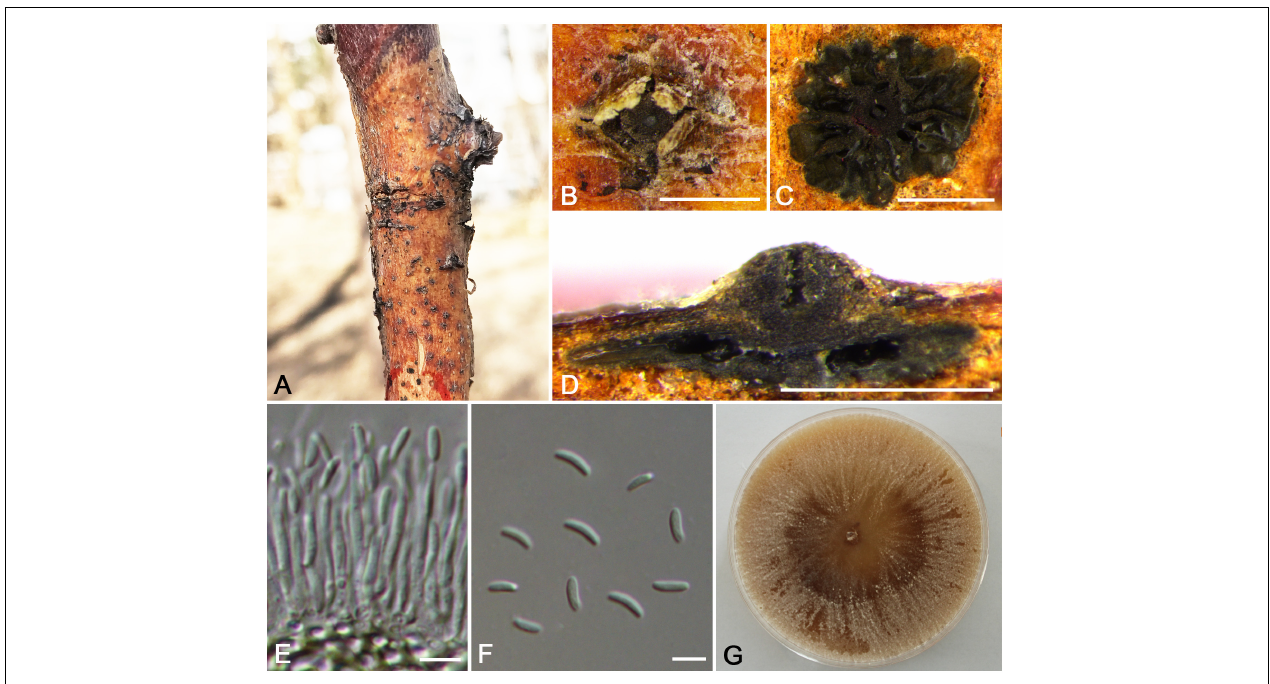
FIGURE 4 | Morphology of Cytospora cinnamomea from Prunus armeniaca (CF 20197654). (A,B) Habit of conidiomata on twig. (C) Transverse section of conidioma. (D) Longitudinal section through conidioma. (E) Conidiophores and conidiogenous cells. (F) Conidia. (G) Colonies on potato dextrose agar (PDA) for 2 weeks. Bars: (B–D) = 500 µ m; (E) = 10 µ m; (F) = 5 µ